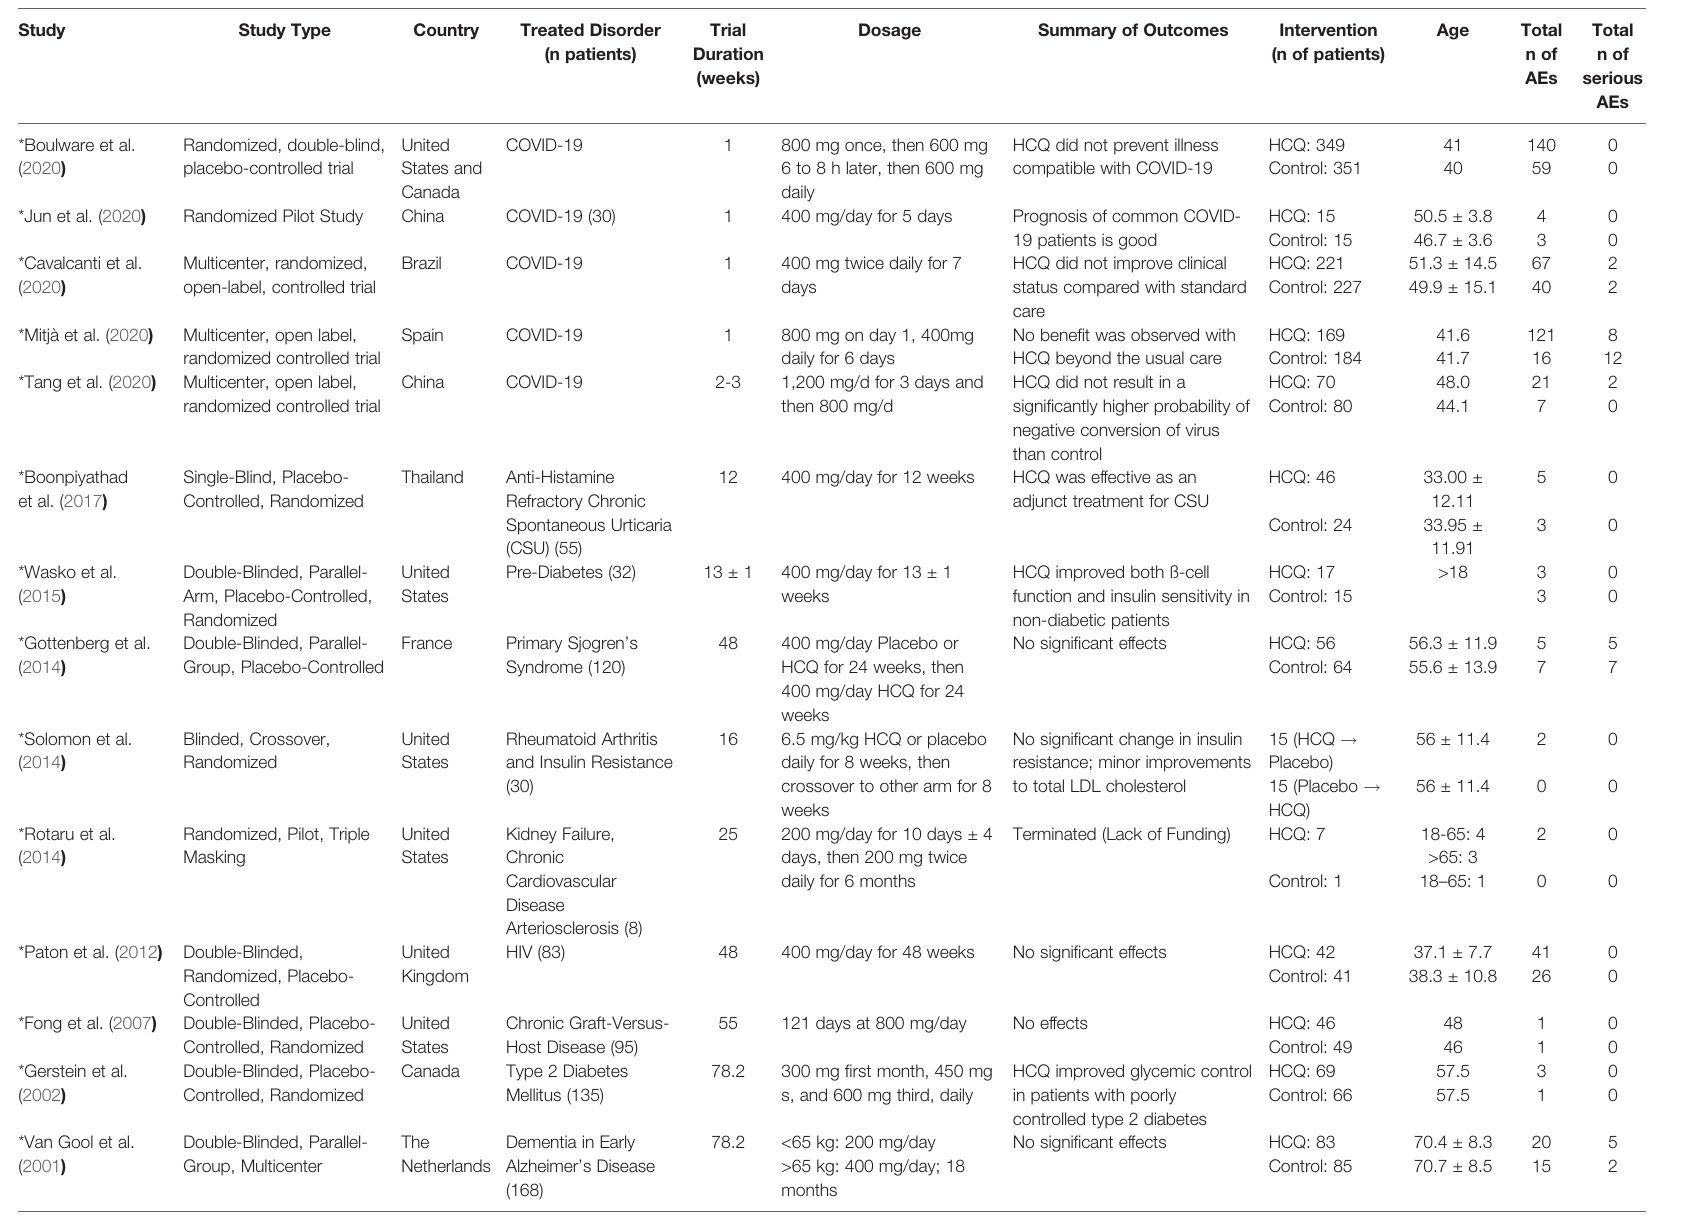
TABLE 2 | Characteristics of HCQ